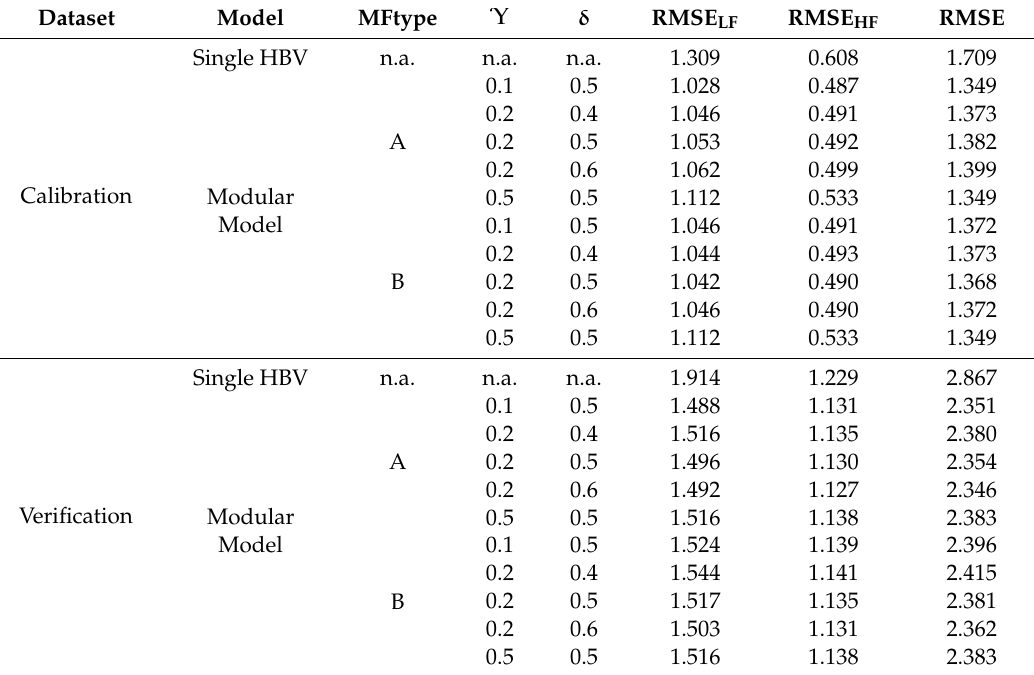
Table 7. Performance of di ff erent modular models compared to the single optimal HBV conceptual rainfall-runo ff